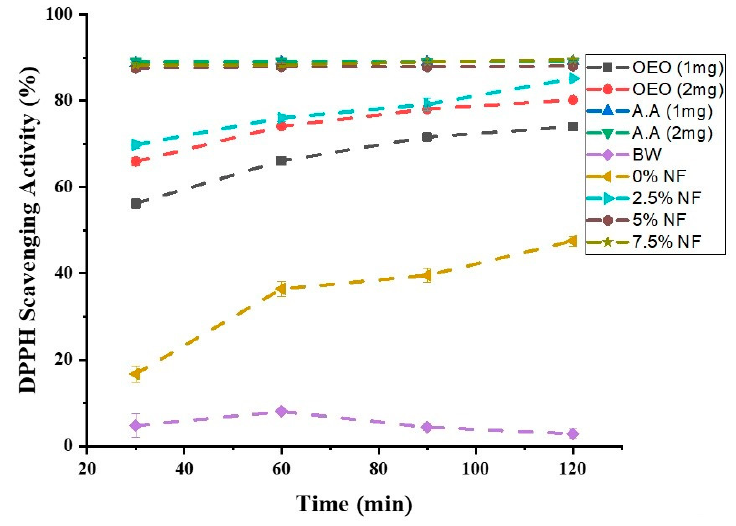
Figure 8. Time-dependent Antioxidant Activity of different groups.